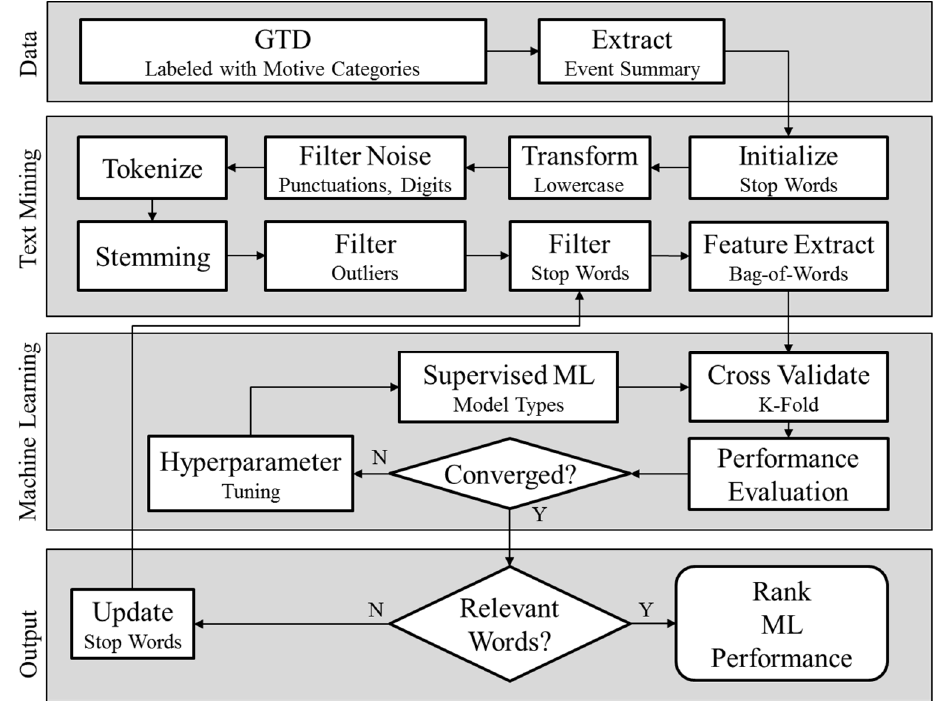
Figure 3. Algorithm for feature extraction by NLP and ML. The cross-validation (K-fold) procedure cyclically partitioned the narratives into